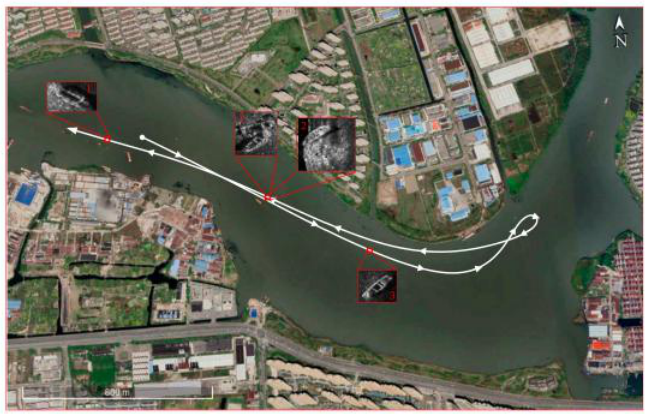
Figure 23. The recognition result of shipwreck